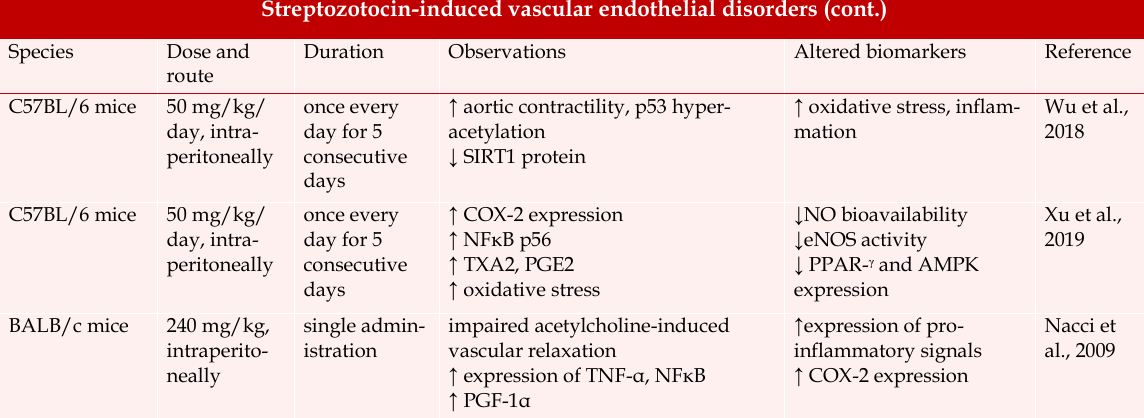
Streptozotocin-induced vascular endothelial disorders